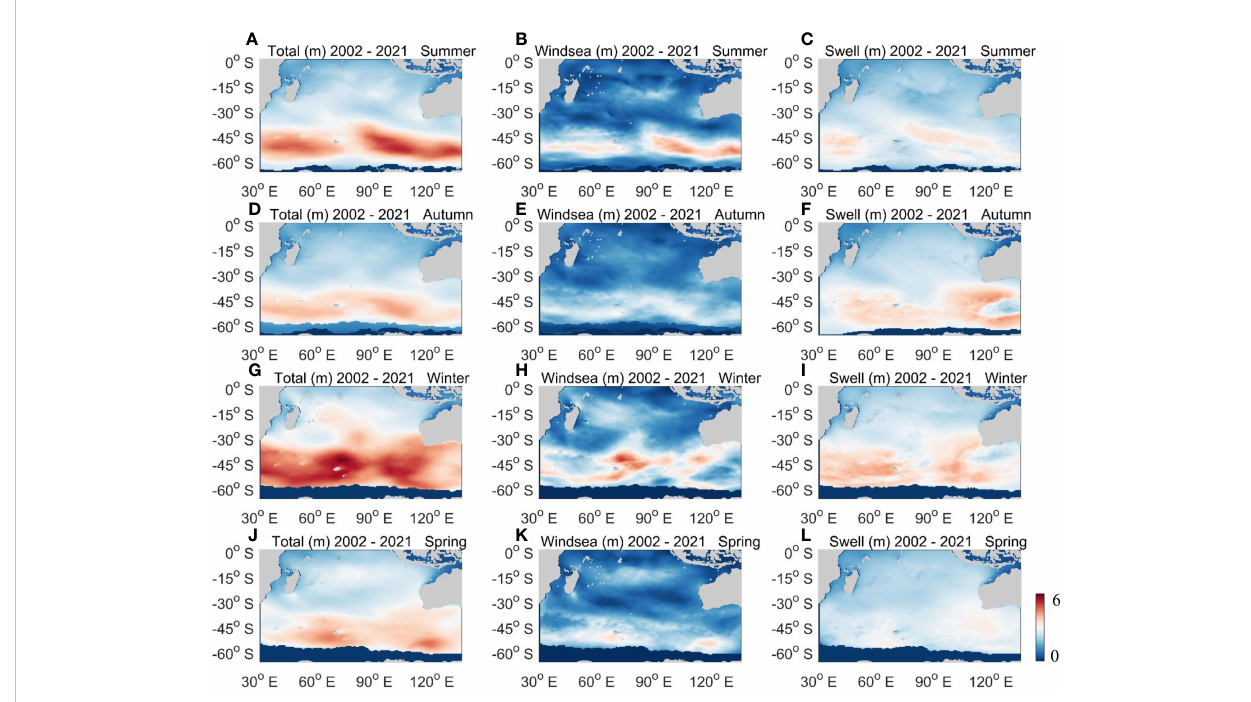
FIGURE 3 Seasonal averages for total SWH (A, D, G, J) , wave height of windseas (B, E, H, K) , and wave height of swells (C, F, I, L) in the Southern Indian